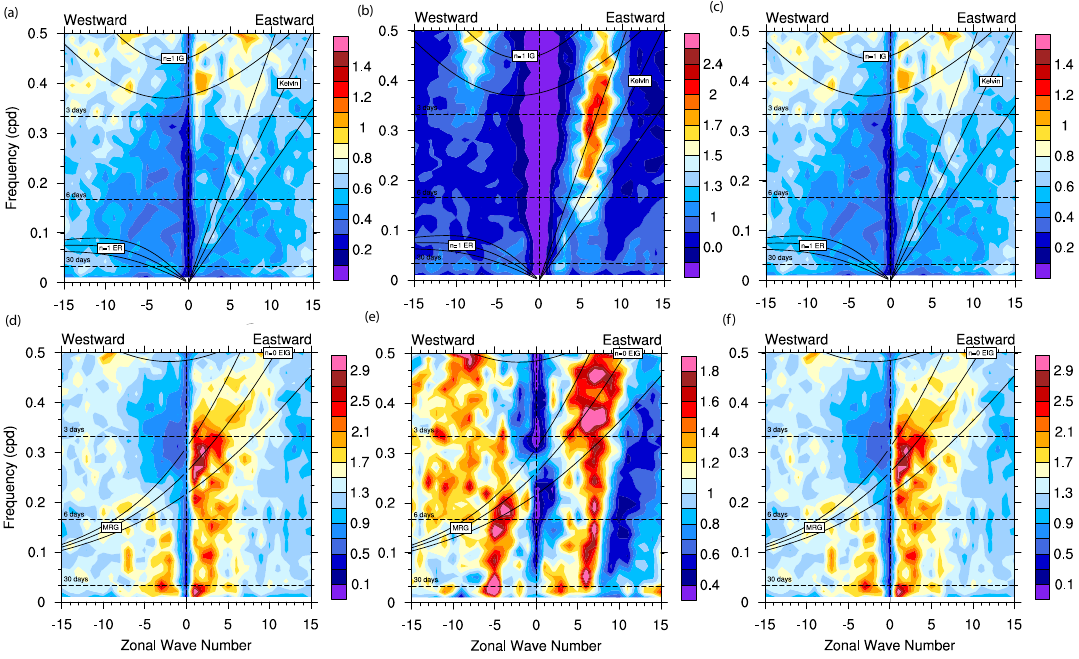
Figure 11. Wavenumber-frequency spectrum of the 200 hPa zonal wind field associated with the eastward inertio-gravity modes. Panels ( a – c ) refer to the symmetric part, while panels ( d – f ) refer to the antisymmetric part. The full spectrum of vertical modes is presented in panels ( a , d ), the barotropic component of the corresponding parts is displayed in panels ( b , e ), and the baroclinic component is illustrated in panels ( c , f